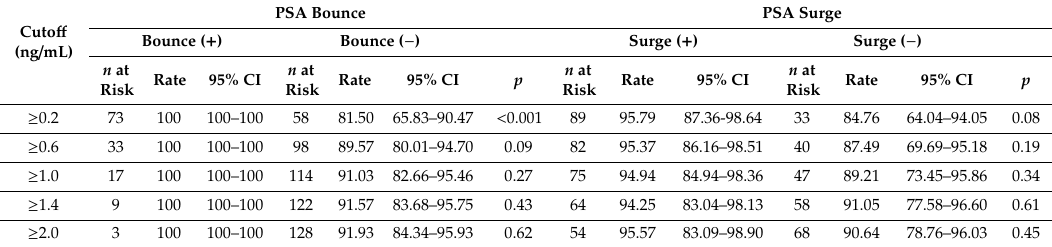
Table 3. Predictive ability of PSA bounce or surge on PSA failure-free survival rate. Cutoff